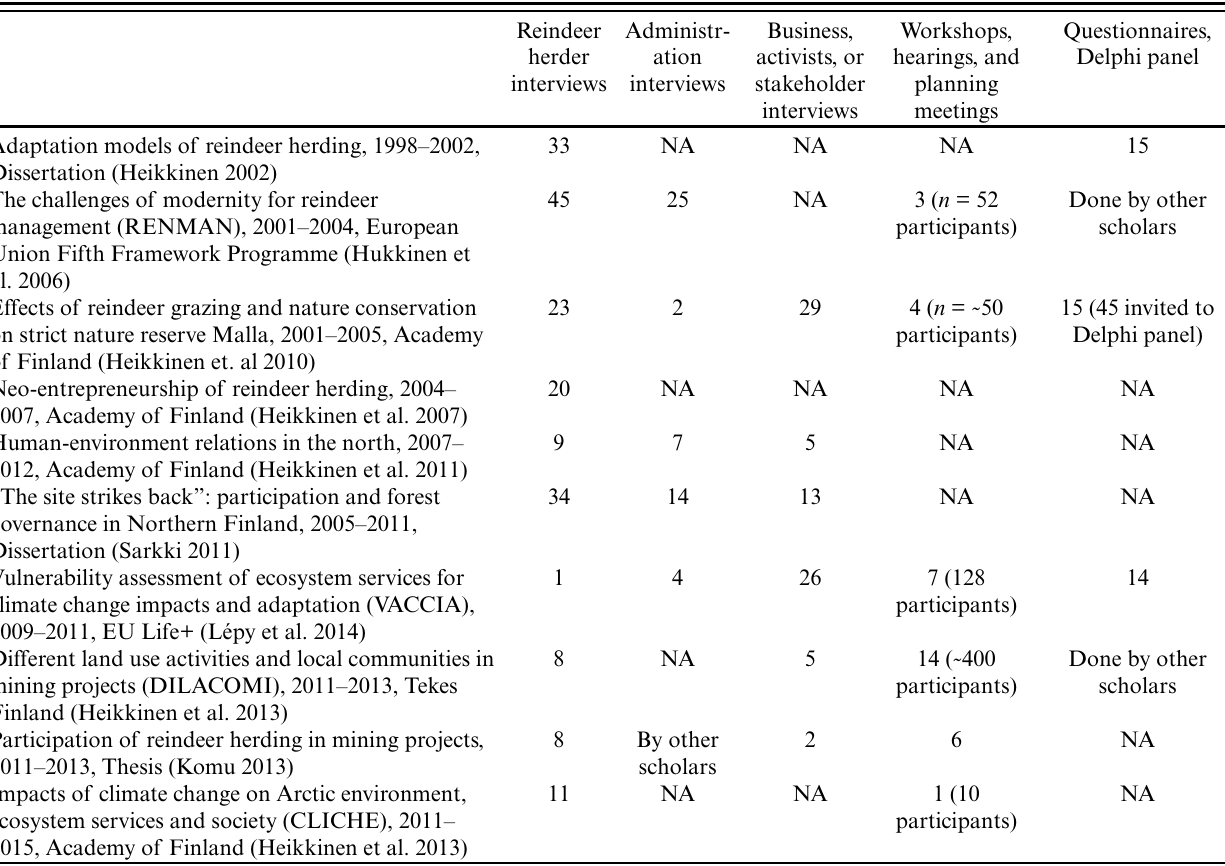
Table 1 . Empirical materials, projects, and publications synthesized for this paper. In the workshops column, the first number is the number of meetings, and n = X is the total number of participants in these